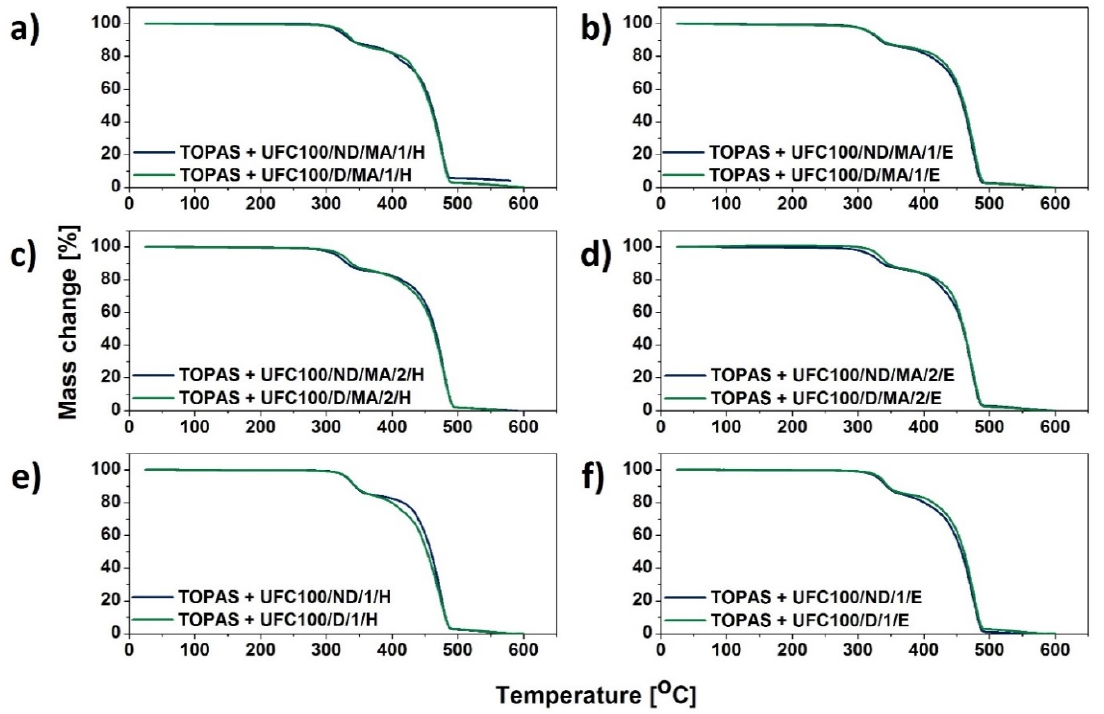
Figure 3. TGA curves of blend samples filled with cellulose fibers: ( a ) solvent exchanged to hexane and then MA treated; ( b ) solvent exchanged to ethanol and then MA treated; ( c ) MA treated and then solvent exchanged to hexane; ( d ) MA treated and then solvent exchanged to ethanol; ( e ) solvent exchanged to hexane; ( f ) solvent exchanged to ethanol. Table 3. Temperatures of the mass loss; T X% —temperature at which the mass loss of x% is